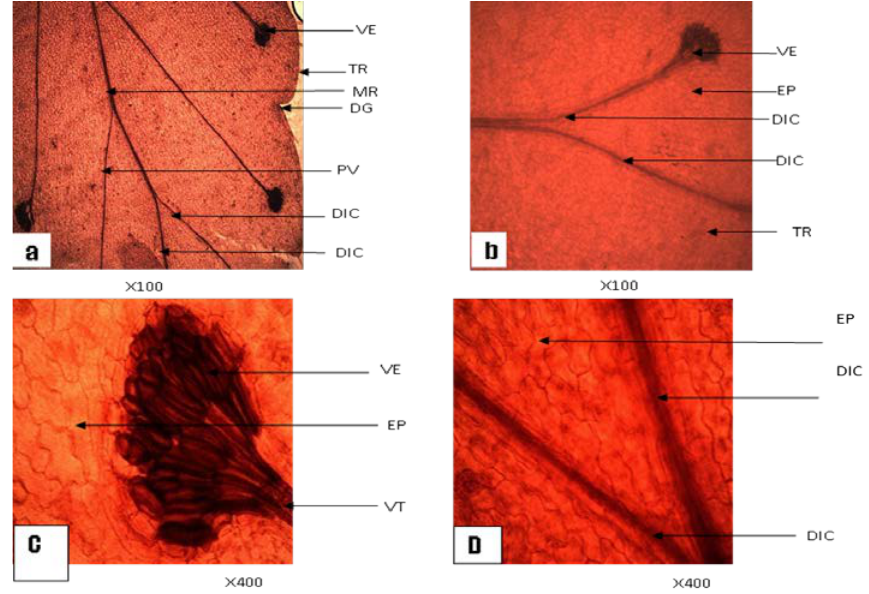
Fig. 2. Venation pattern of the leaflet of N . exalta (i)